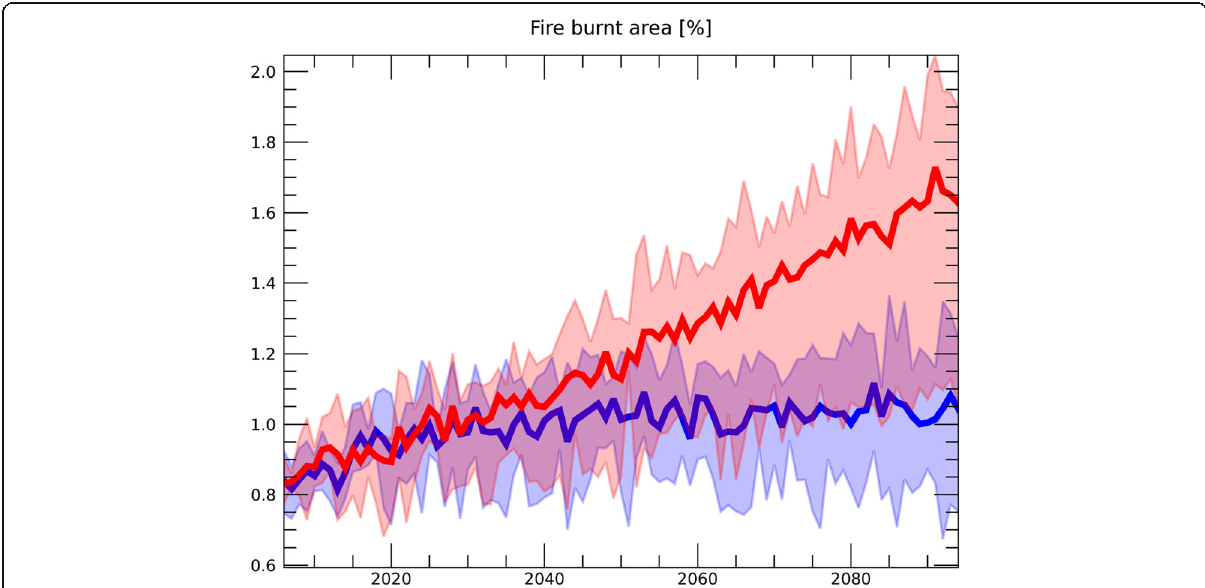
Fig. 3 Time sequence for the probability of fire in the RCP8.5 (red) and RCP2.6 (blue) scenarios. Unit is the ratio (%) to the total land area above 50° N. The width of the colored area represents the 68 percentiles of the 300 simulations with different model parameters, as explained in